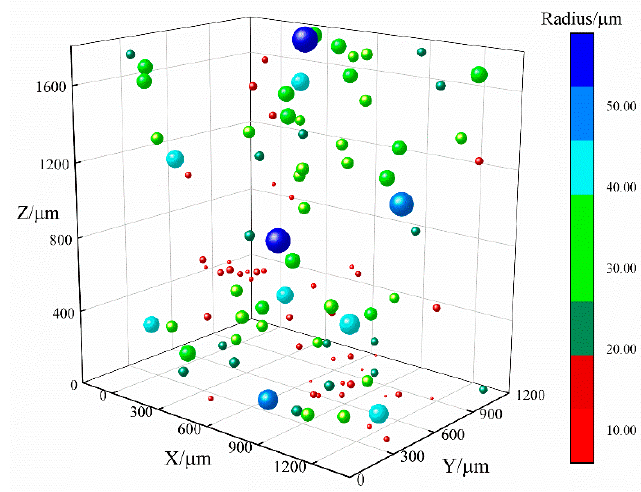
Figure 2. Schematic diagram of the bubble distribution in the crucible space.